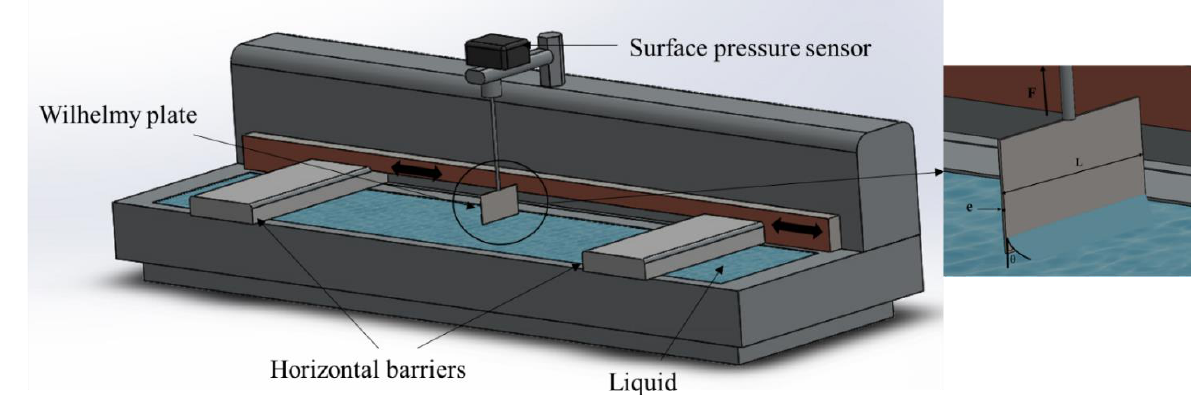
Figure 17. Schematic diagram of the Langmuir balance.